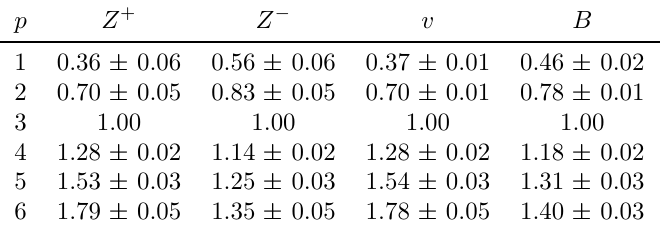
Table 3: Normalized scaling exponents 𝜉 𝑝 /𝜉 3 for Alfv´enic, velocity, and magnetic fluctuations obtained from data of high resolution 2D MHD numerical simulations. Scaling exponents have been calculated from spatial fluctuations; different times, in the statistically stationary state, have been used to improve statistics. The scaling exponents have been calculated by ESS using Equation (41) as characteristic scale rather than the third-order structure function (cf. Politano et al. , 1998, for details). 𝑝 𝑍 + 𝑍 − 𝑣